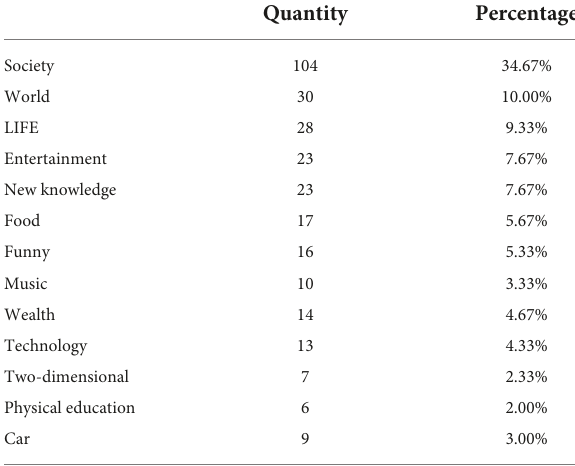
TABLE 1 Topic distribution of Z Video news and information